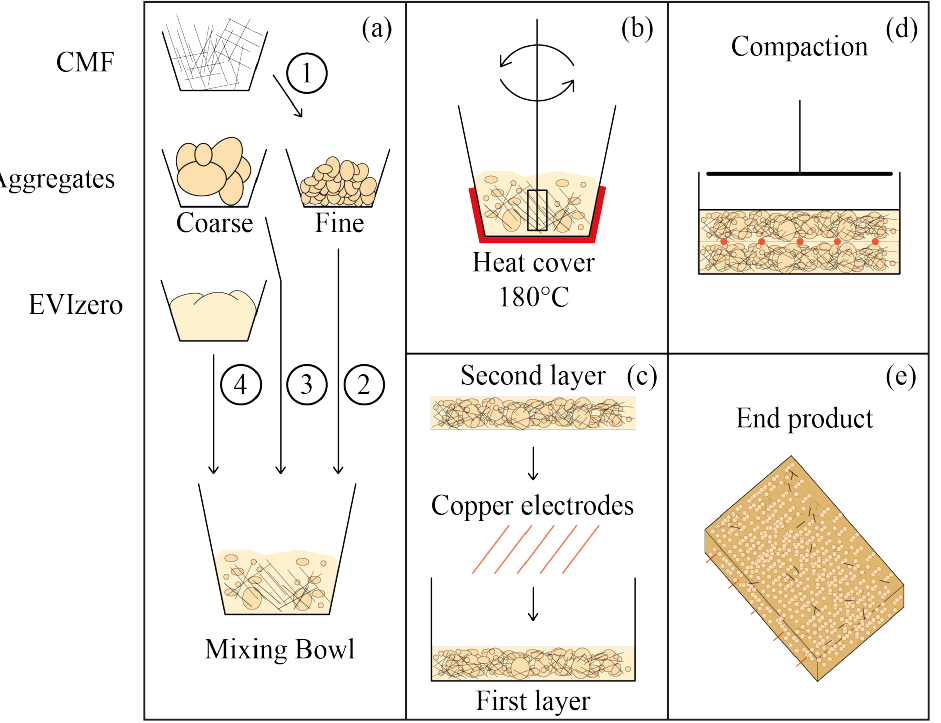
Figure 1. Smart pavement fabrication steps: ( a ) Mixing of dry materials with the melted EVIzero; ( b ) mechanical mixing under 180 ◦ C; ( c ) casting of sample; ( d ) compaction of sample; and ( e ) smart slab constructed from half of the compaction sample. Table 2. Mix design of the composite for one plate